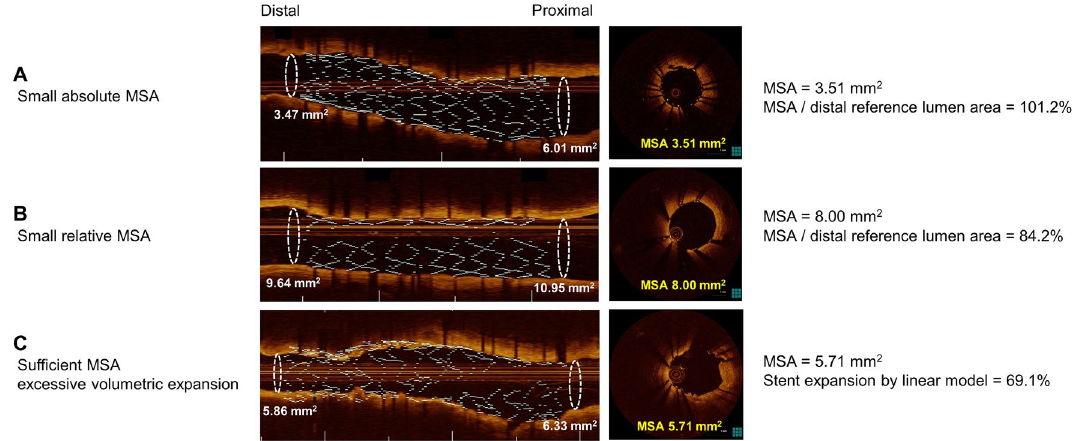
Figure 4. Representative OCT images of suboptimal stent expansion resulting in adverse outcomes. ( A ) MSA is small (< 5.0 mm 2 ), resulting in TLR. ( B ) MSA is larger than 5.0 mm 2 but the ratio of MSA by distal reference lumen area is less than 90%, resulting in TLR. ( C ) MSA is larger than 5.0 mm 2 and volumetric stent expansion